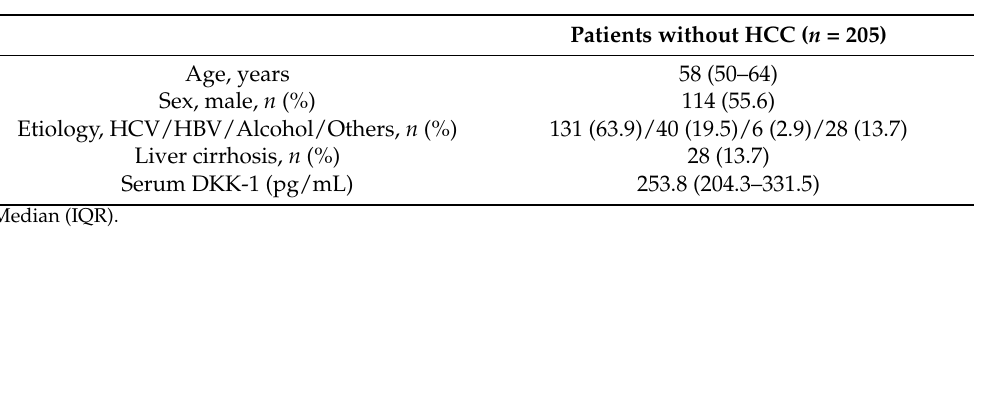
Table 2. Characteristics of patients without hepatocellular carcinoma